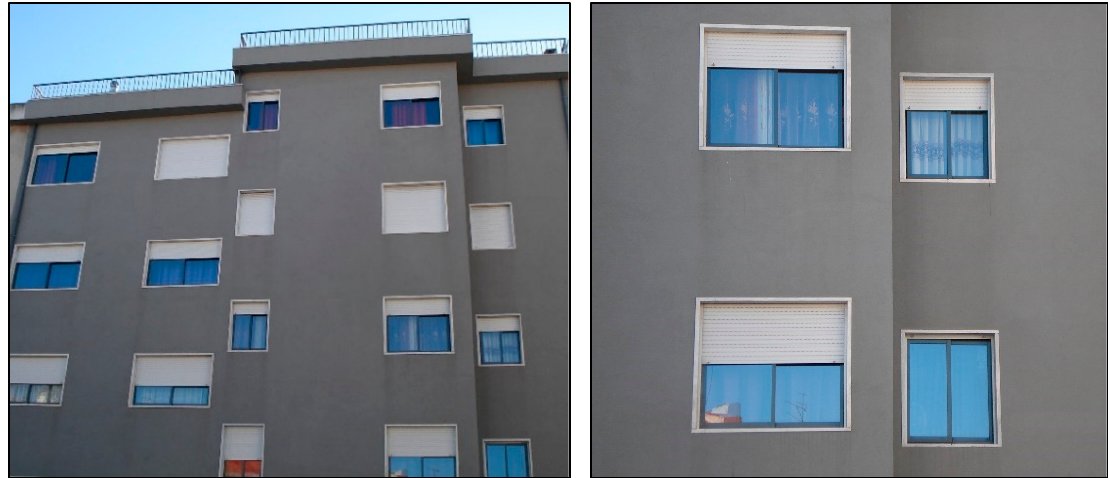
Figure 3. Case study of an ETICS inspected in 2016.